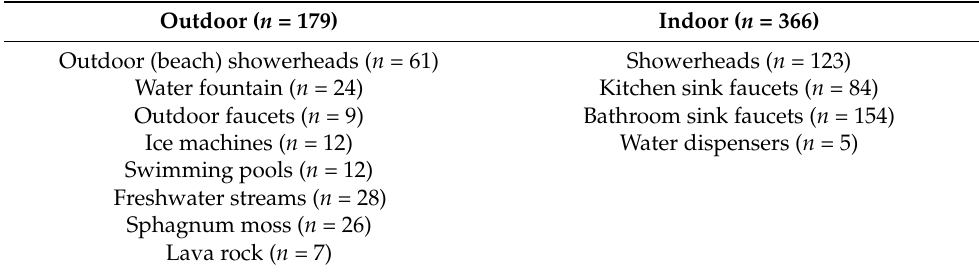
Table 1. Types and number of outdoor and indoor biofilms